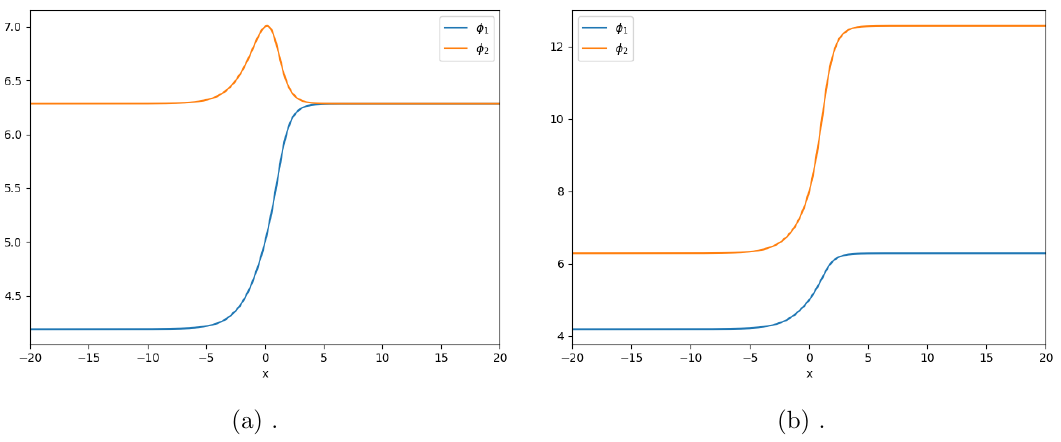
Figure 2. Two numerically calculated BPS states of the model with (cid:13) i = 1.